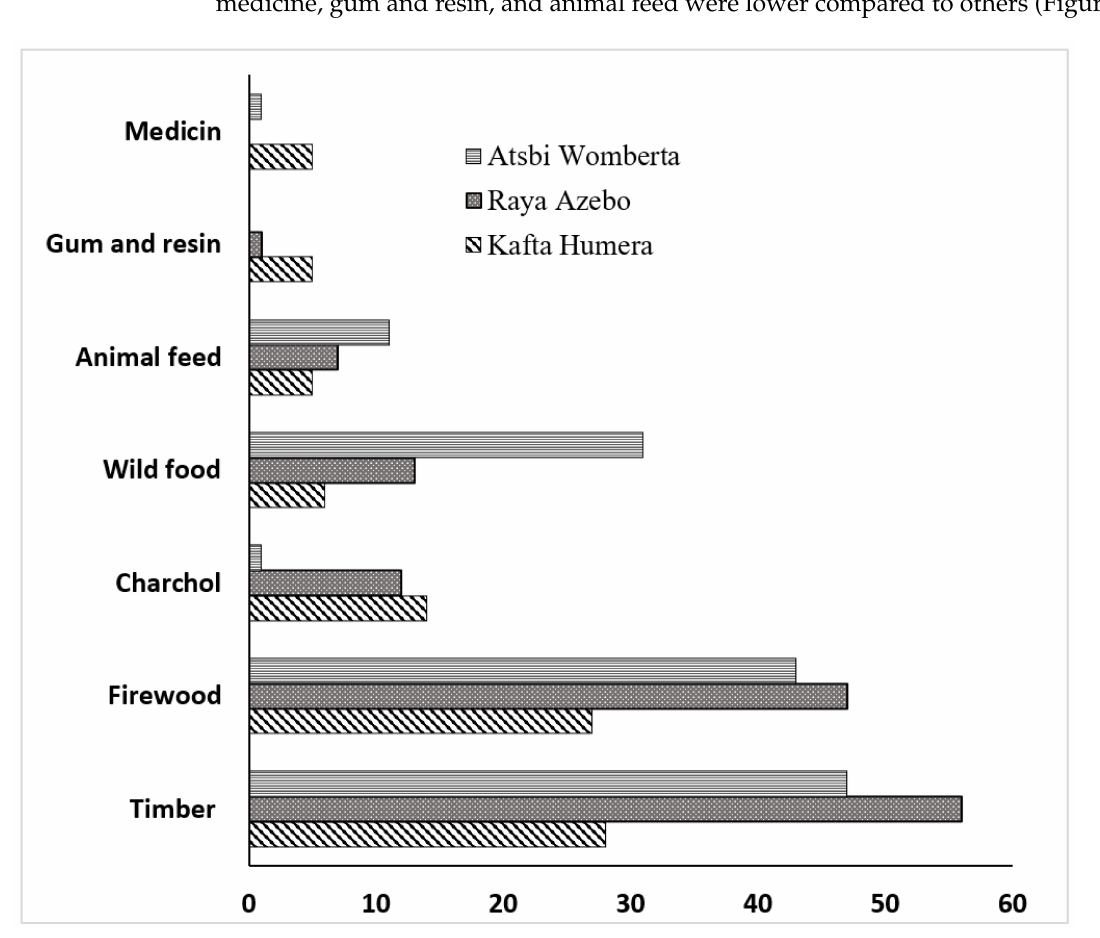
Figure 5. Proportion of households collecting forest products from dry forests in the three